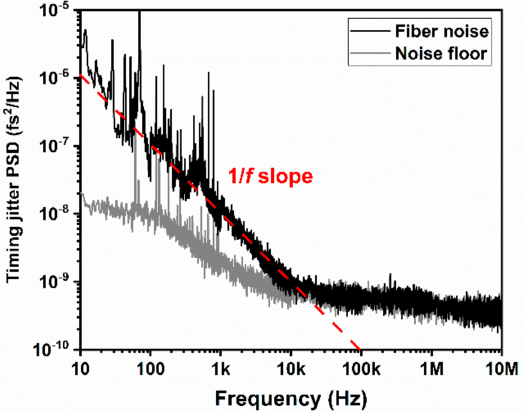
Figure 3. Timing jitter PSD of 5-m long single mode fiber using OH technique.